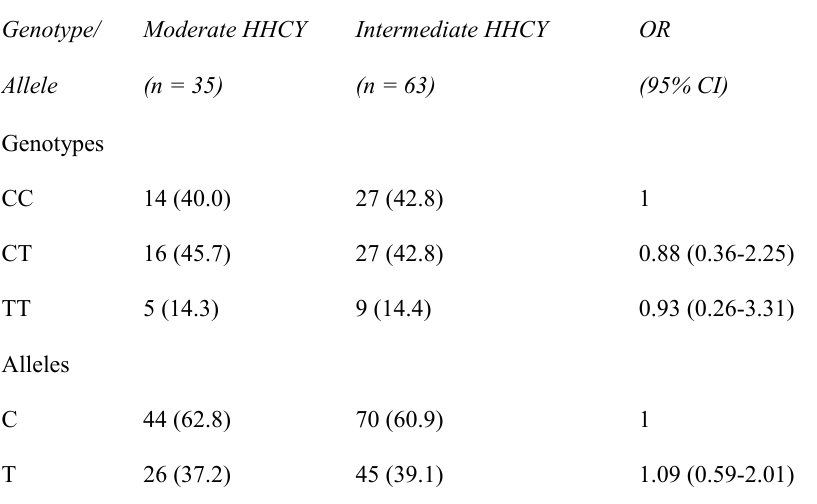
Values in parentheses denote genotype frequencies (columns 2 and 3) or 95% CI (column